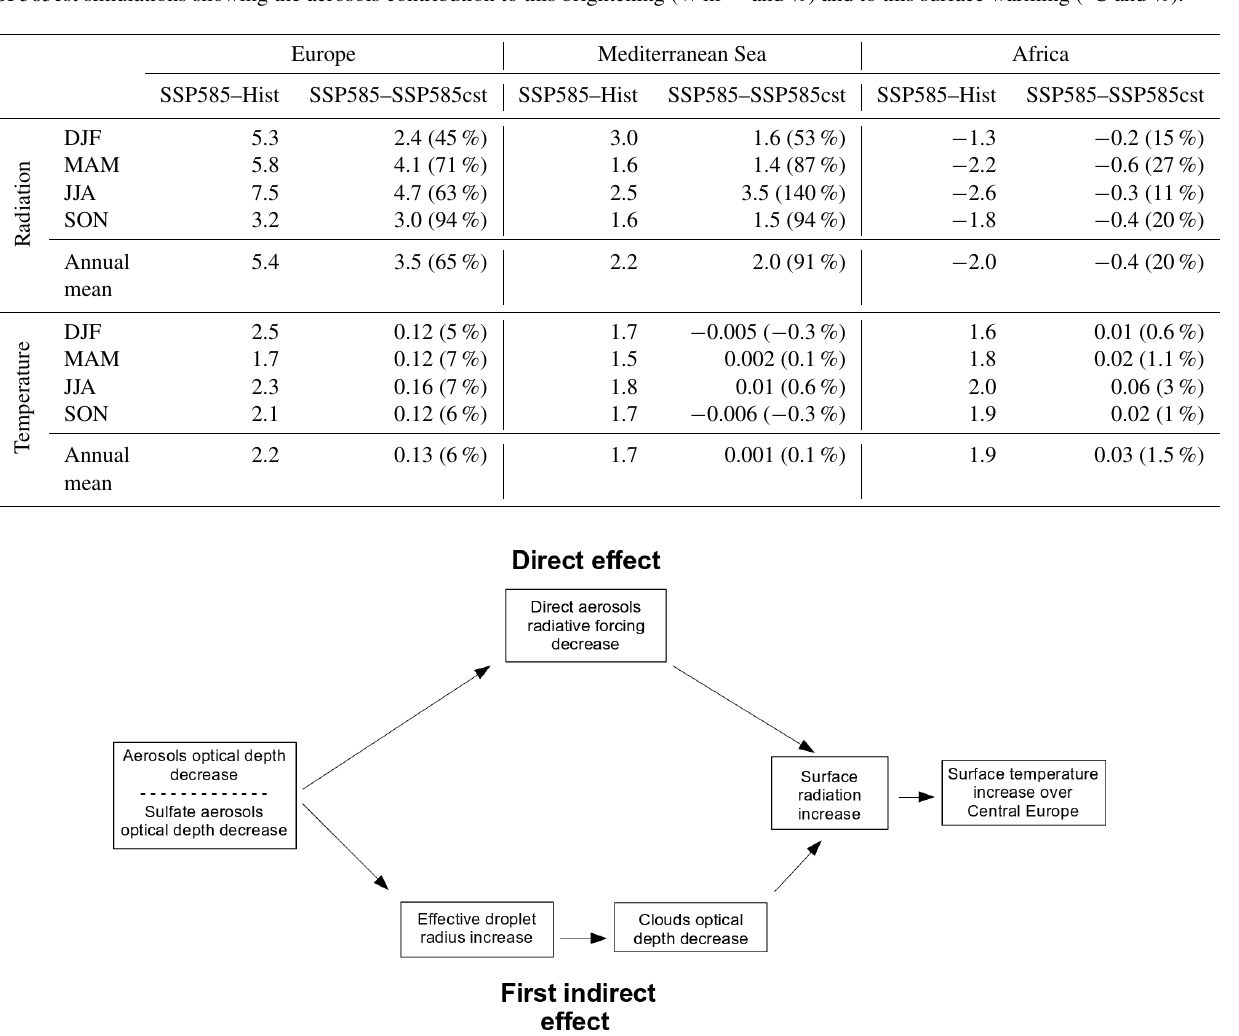
Table 4. Average differences between the SSP585 and Hist simulations showing the surface radiation (Wm − 2 ) and the surface temperature ( ◦ C) increase over Europe, the Mediterranean Sea and Africa between the periods 1971–2000 and 2021–2050 and between the SSP585 and SSP585cst simulations showing the aerosols contribution to this brightening (Wm − 2 and %) and to this surface warming ( ◦ C and %).